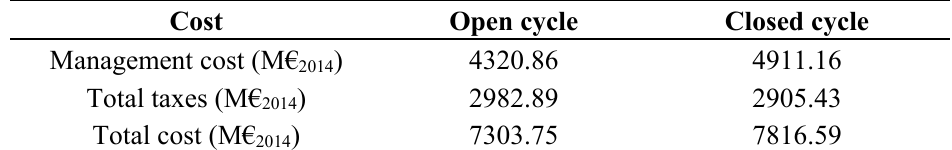
Table 5. Total costs for each alternative through all period of study 2014–2028